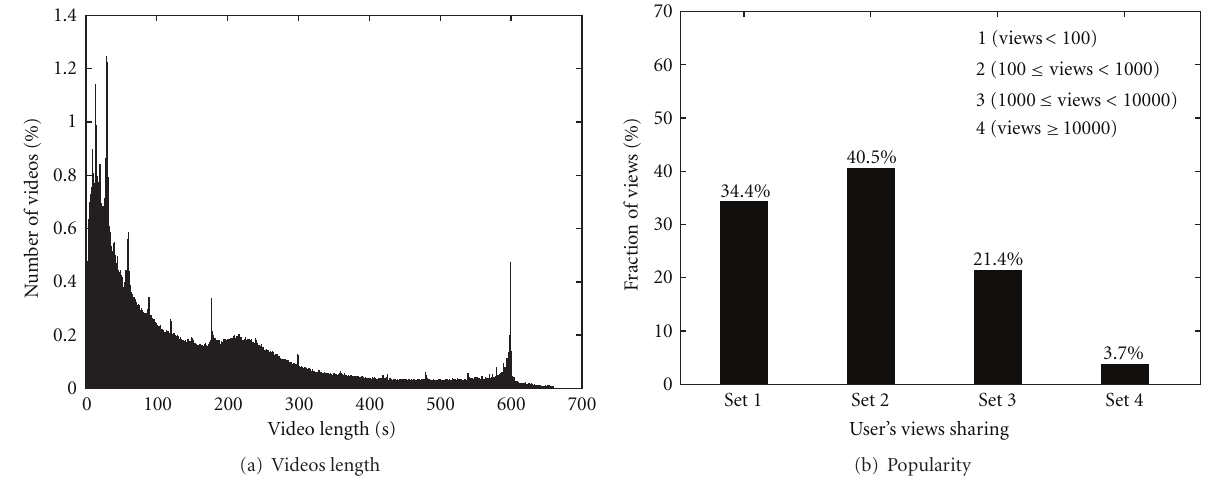
Figure 1: Statistics for YouTube Entertainment category